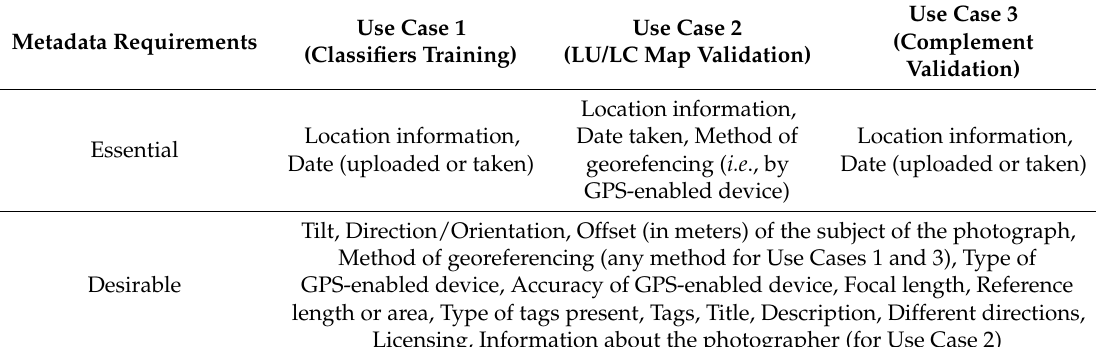
Table 4. Categorization of the metadata into essential, desirable and unnecessary by use